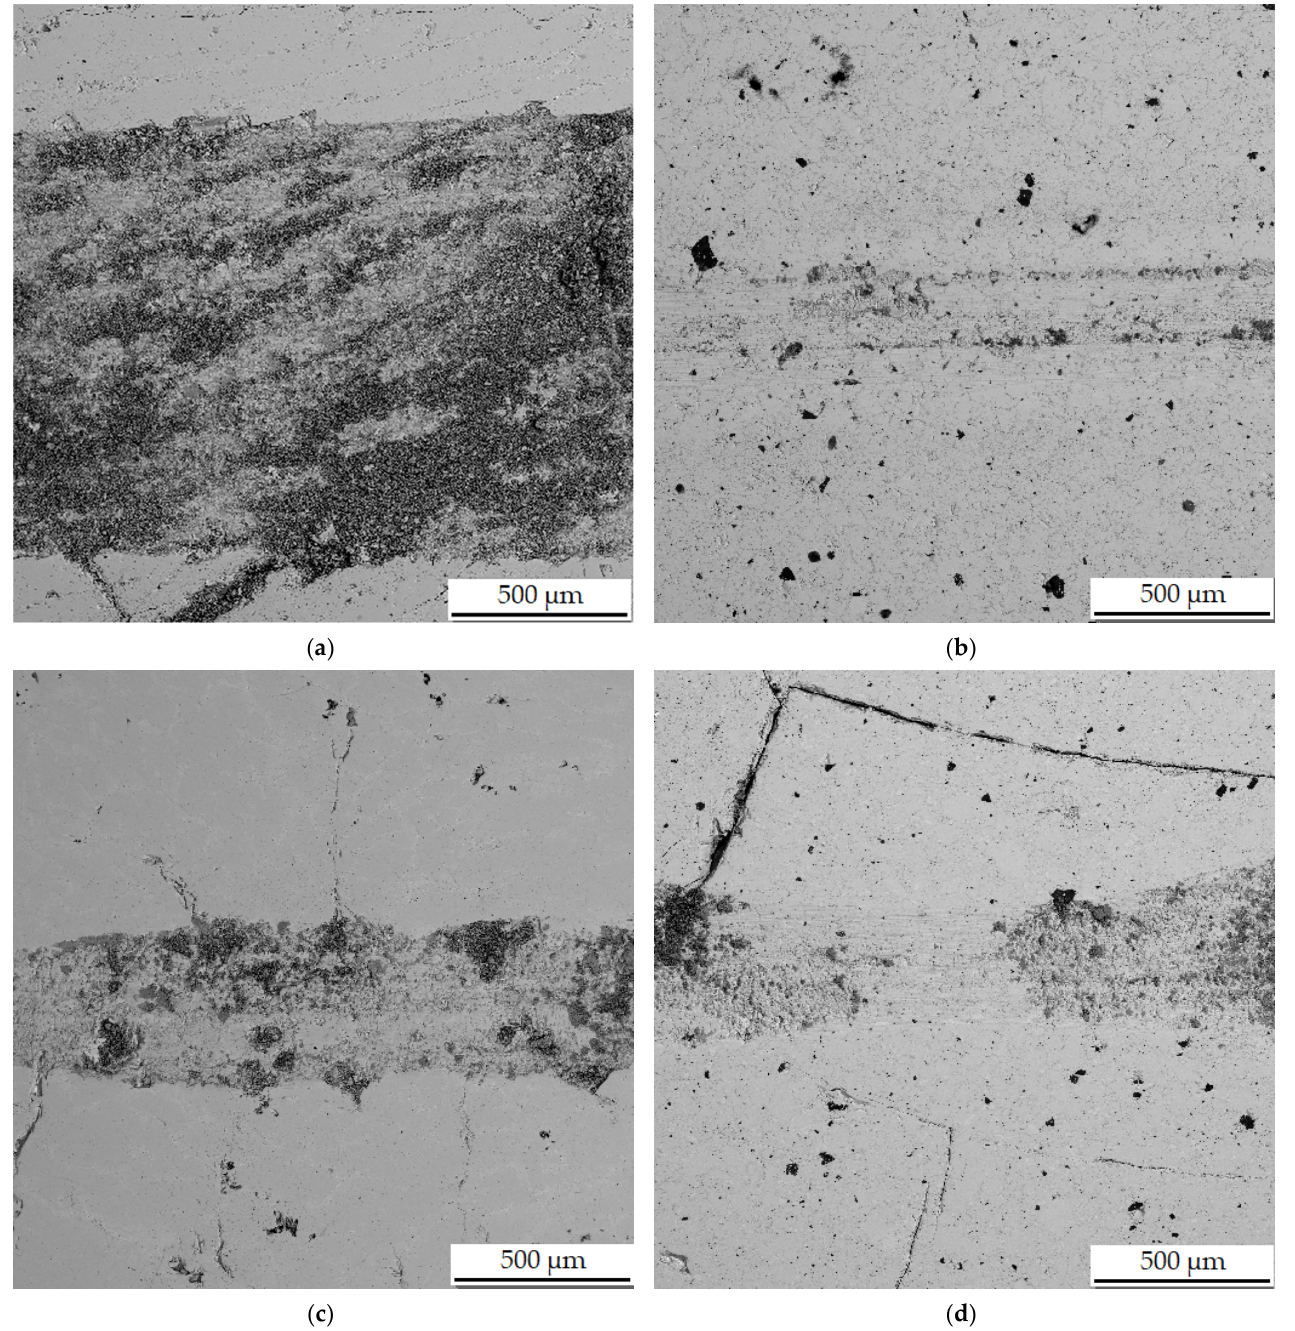
Figure 15. Wear tracks on aluminothermically prepared samples after testing with Al 2 O 3 ball as the static partner. ( a ) Alloy with 100% excess of aluminum over stoichiometry in the reduced state; ( b ) alloy sintered at 900 °C; ( c ) alloy sintered at 950 °C; ( d ) alloy sintered at 900 °C and heat-treated by annealing at 800 °C for 3 h.